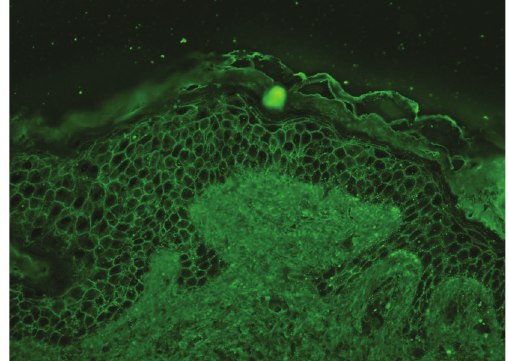
Figure 5: Direct immunofluorescence of the perilesional skin. Intercellular deposits of IgG throughout epidermis.